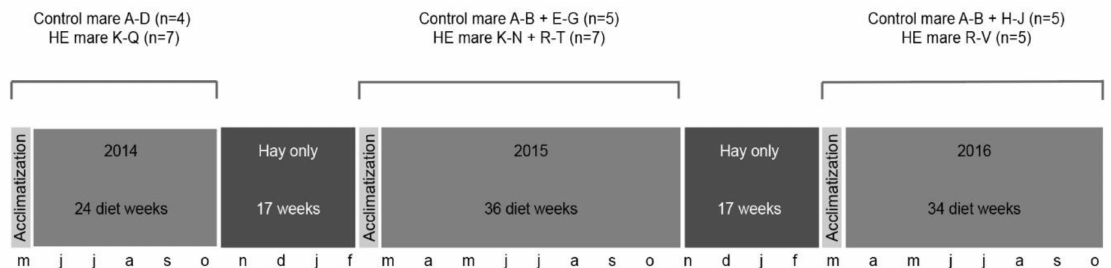
Figure 1. Organization of the feeding periods during study years 2014 to 2016, including the acclimatization periods (i.e., a one week period during which the high-energy (HE) diet was built up gradually to the full ration), the number of weeks during which the diet was fed and the hay-only periods in between, with the corresponding months. The ponies in the control (maintenance diet) and high-energy (HE; diet equating to 200% of net energy requirements) groups are described per study